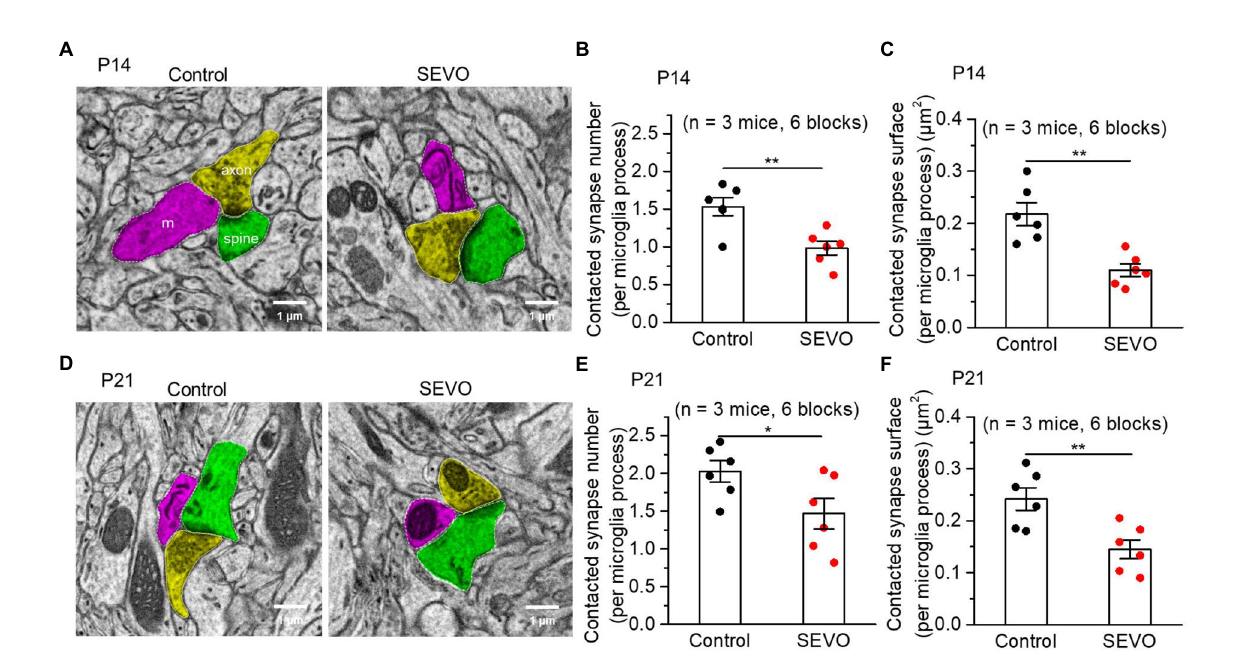
FIGURE 6 Spatial relationship between microglia and synaptic structure after prolonged neonatal sevoflurane exposure. (A) Representative SBF-SEM images of microglia and synapse 7 days after prolonged sevoflurane exposure. Magenta: microglia processes; Yellow: axon; Green: spine. (B) Quantification of synapse number contacted by per microglia process 7 days after prolonged neonatal sevoflurane exposure ( p = 0.005, two-sample t -test). (C) Quantification of contacted synapse surface area by per microglia process 7 days after prolonged sevoflurane exposure ( p = 0.002, two-sample t -test). (D) Representative SBF-SEM images of microglia and synapse 14 days after prolonged sevoflurane exposure. (E) Quantification of synapse number contacted by per microglia process 14 days after prolonged neonatal sevoflurane exposure ( p = 0.047, two-sample t -test). (F) Quantification of contacted synapse surface area by per microglia process 14 days after prolonged sevoflurane exposure ( p = 0.007, two-sample t -test). Data are shown as mean ±